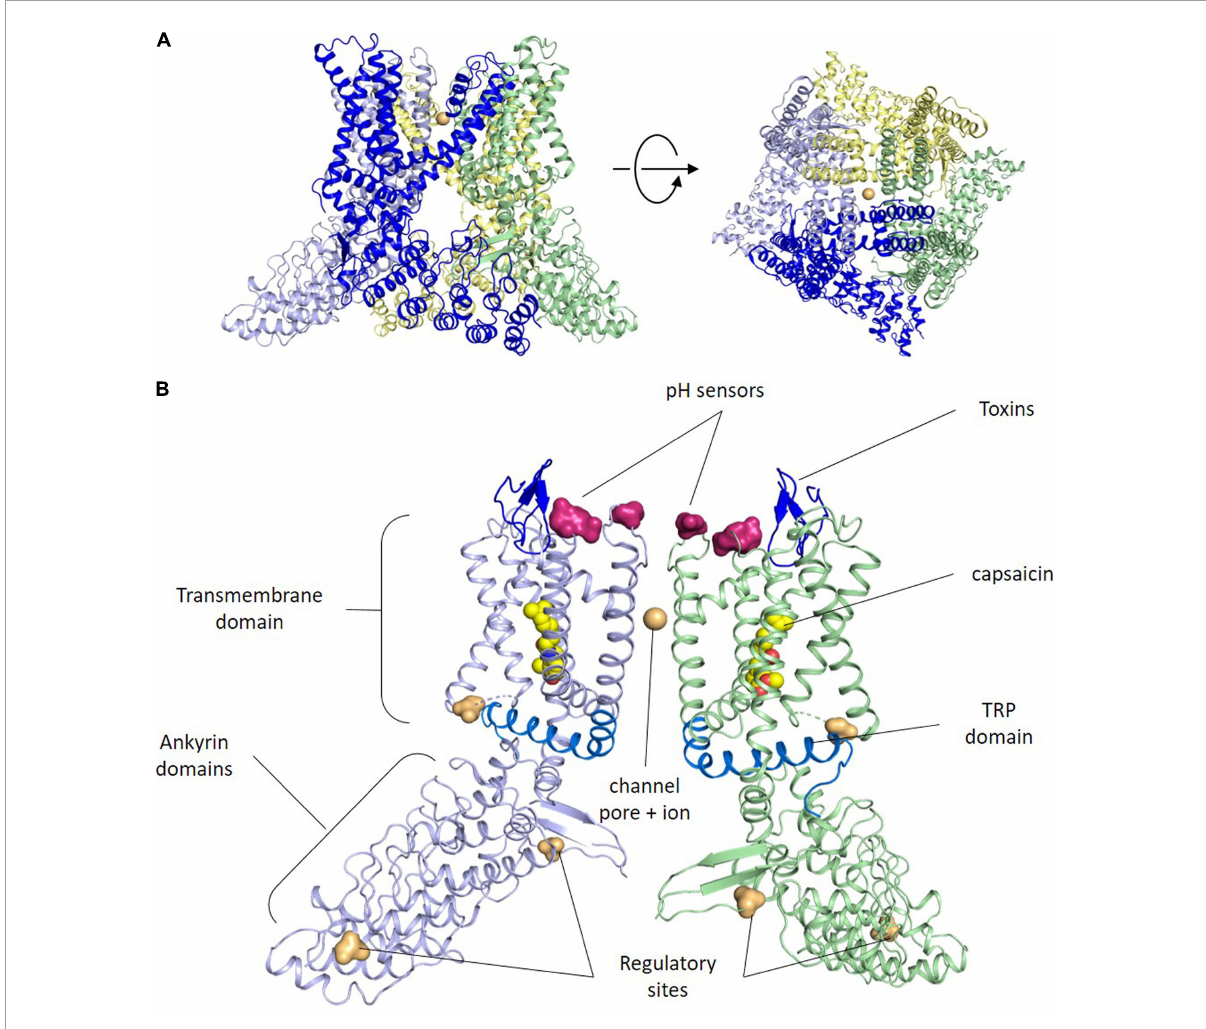
FIGURE1 TRPV1 structure. (A) Side and upper views of tetrameric arrangement of the full human TRPV1 in the closed state. Each subunit of the TRPV1 channel is made up of six transmembrane domains. The pore loop is located between the S5 and S6 segments. Both the N and C termini are located Intracellularly. Sodium ions are shown as orange spheres. Contacts between monomers occur mainly in the membrane domain and at the C-terminus coiled–coil domain that lies around the central axis and surrounded by the N terminus. (B) Side view of the ribbon structural model of two opposite monomers of TRPV1 channel. The other two monomers are not shown for clarity. Amino acid residues specific for capsaicin and proton activation, as well as residues important for toxins binding, phosphorylation by protein kinases A and C ( PKA , PKC ) and Ca 2 + -calmodulin-dependent kinase II ( CaMKII ) kinases are highlighted at both intra-cytoplasmic